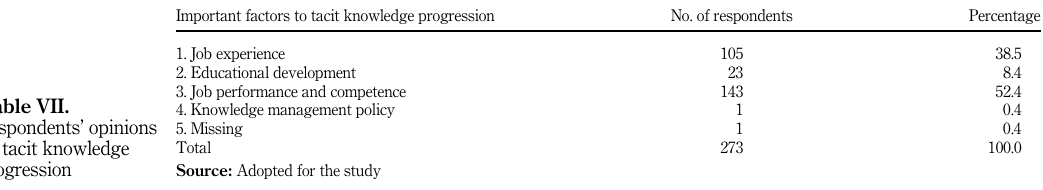
Table VI. Knowledge sharing acquiring experiences (adopted for the study)